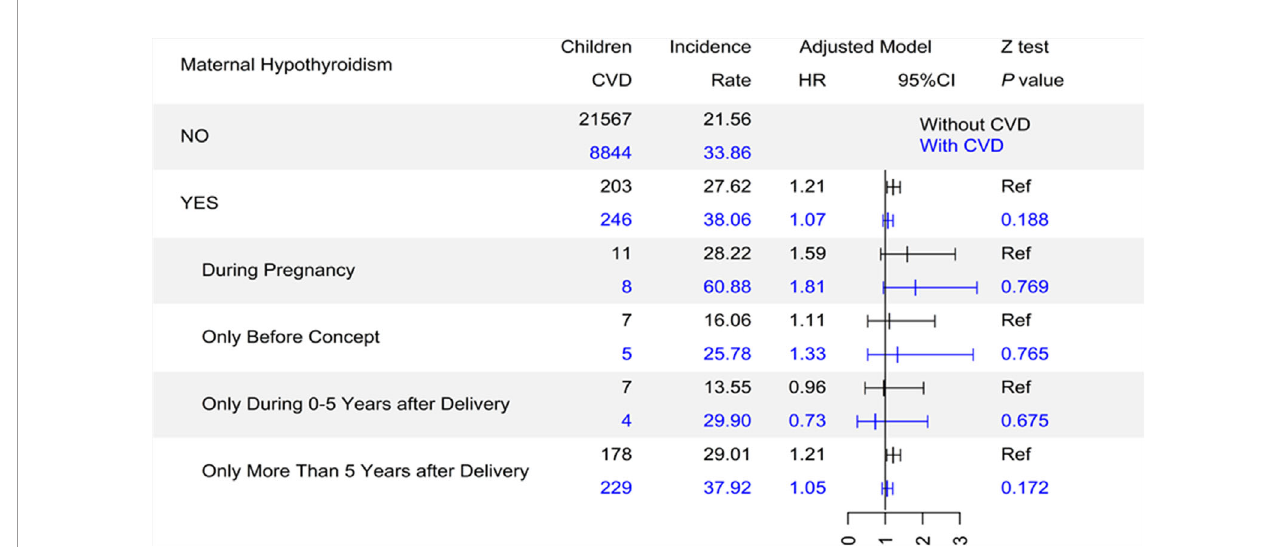
FIGURE 2 | The association between maternal hypothyroidism and offspring ’ s CVD strati fi ed by maternal CVD. CVD, cardiovascular disease; Incidence rate, incidence rate per 1000 person-years; HR, hazard ratio; CI, con fi dence interval; Ref, reference